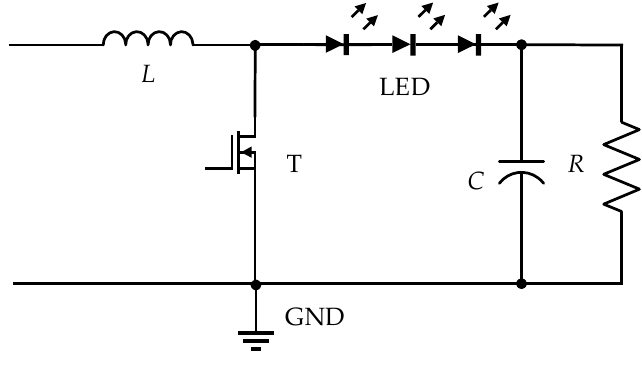
Figure 3. LED Boost converter.